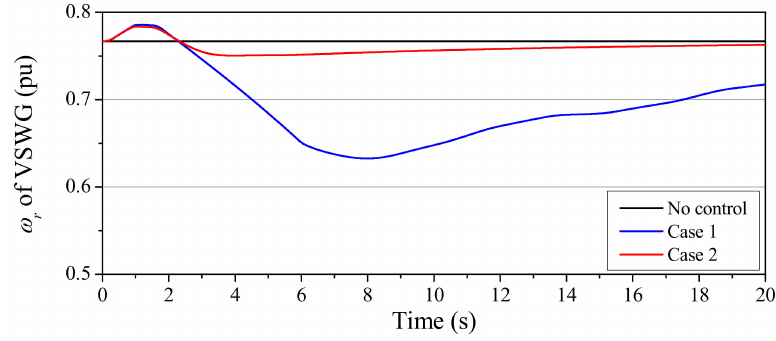
Figure 15. Rotor speed of the VSWG (with SG3 installed).